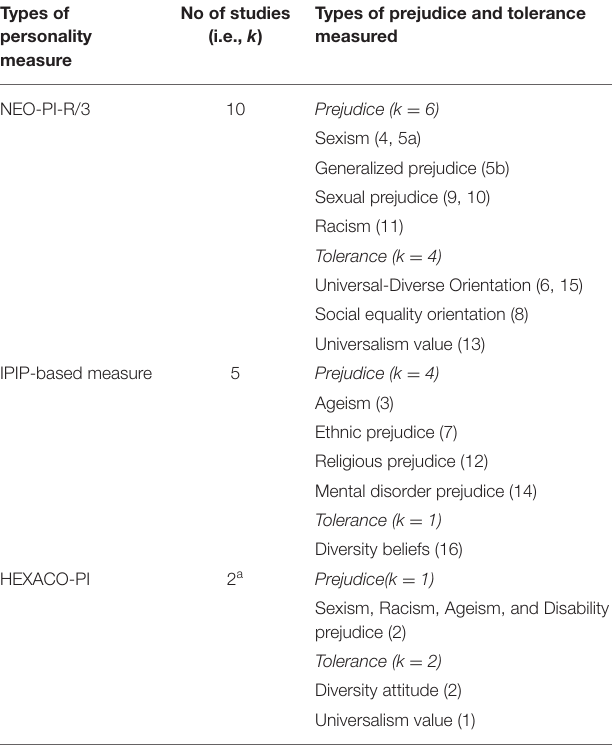
TABLE 3 | Categorization of included